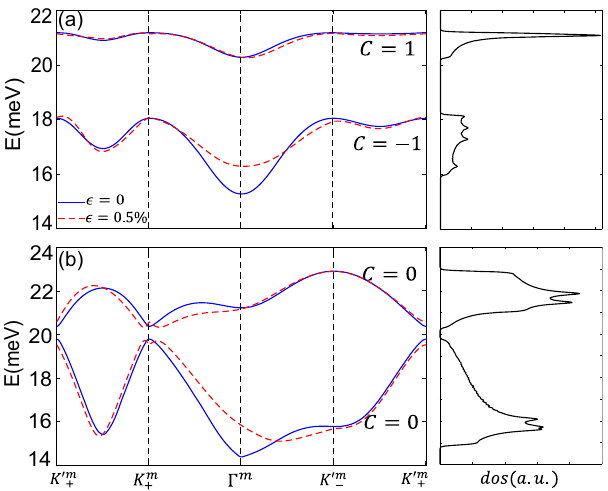
Fig. 2 The band structure and density of states (dos) of tWSe 2 . a The band structureoftWSe 2 at θ = 1.4 ∘ with (dashed red lines) and without (solid blue lines) strain. The staggered potential V z = 0 and the top two valence bands originating from K + valleys of the original monolayer Brillouin zone have opposite Chern numbers. The bands originating from the K − valleys are related to the K + valley bands by time-reversal which are not shown above. b The band structure with V z = 5meV with (dashed red lines) strain and without (solid blue lines) strain. As V z increases, a topological phase transition happens at V z ≈ 4.2meV and the two top valence bands exchange Chern numbers and results in topologically trivial fl at